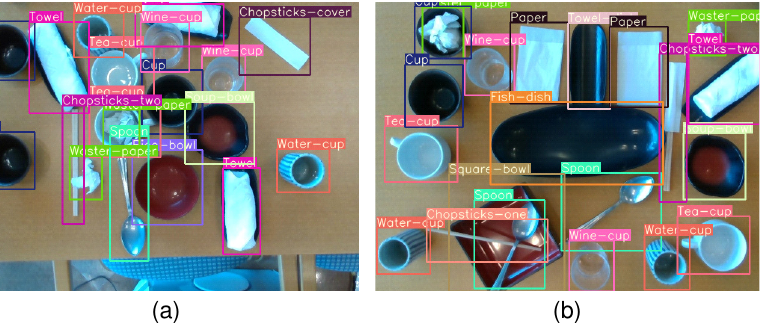
Figure 3. Examples of 16 kinds of dishes in the training dataset. ( a ) first example, ( b ) second